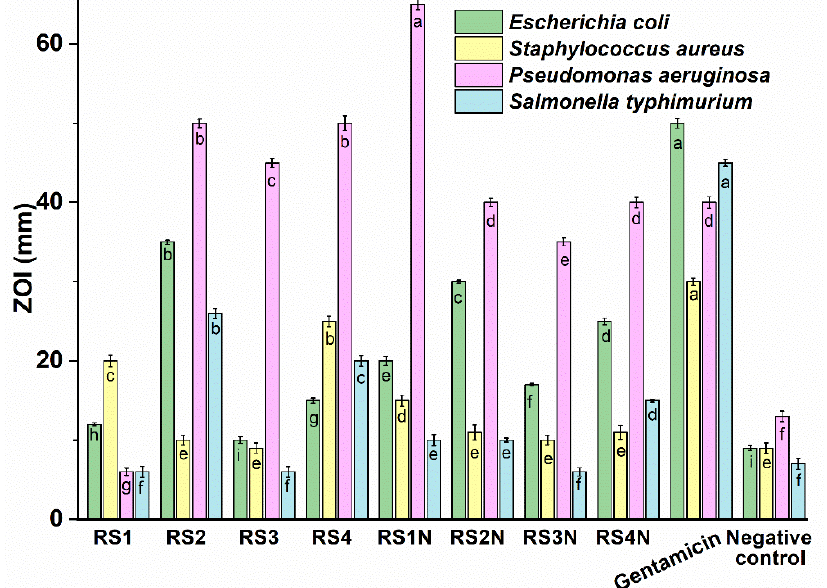
Figure 4. Antibacterial activity of tested extracts against four bacterial strains. For each strain, values without a common letter differ ( p < 0.05) as analyzed by one-way ANOVA and the Tukey test. The diameter of the inhibition zone for the phytosynthesized nanoparticles varied from 7.38 ± 0.21 mm (RS3N against S. typhimurium ) to 65.67 ± 0.91 mm (RS1N against P. aeruginosa ) for the tested samples, compared with the values obtained for the positive control gentamicin (30.33 ± 0.44 mm against S. aureus to 50.10 ± 0.62 mm against E. coli ) (see